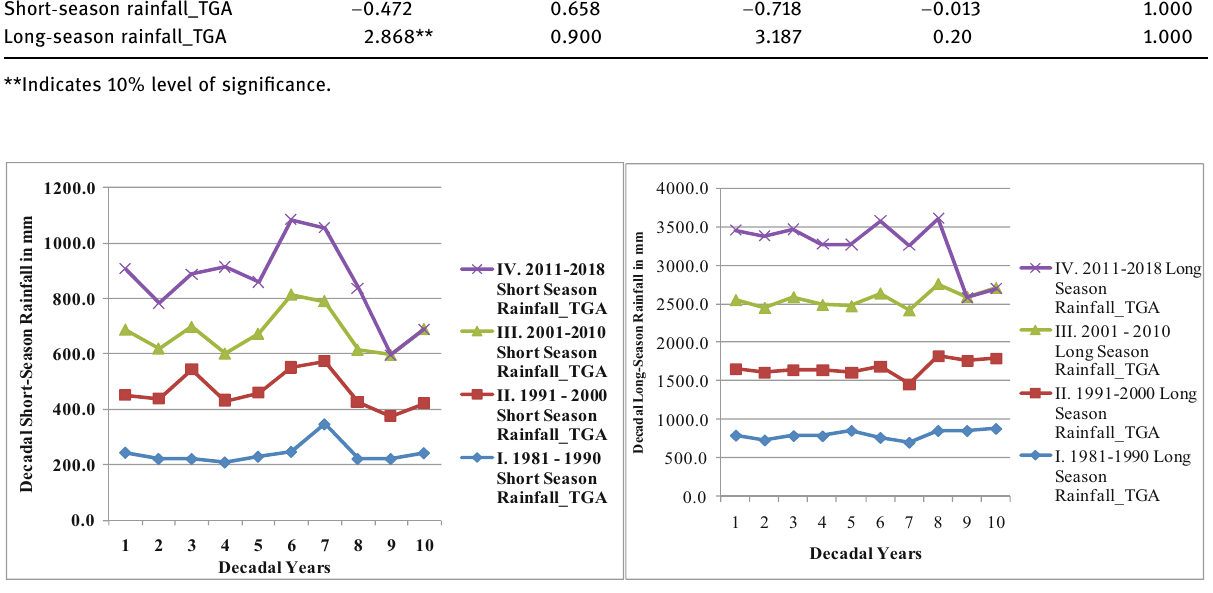
Figure 4: Pattern and trend of decadal short - and long - season rainfall in te ff growing